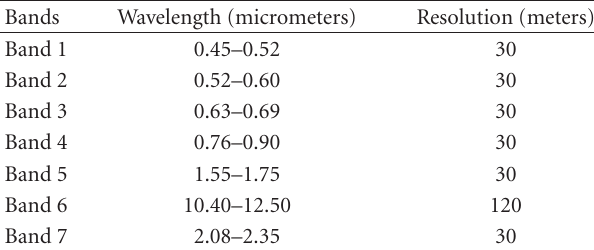
Figure 2: Location map of study area.